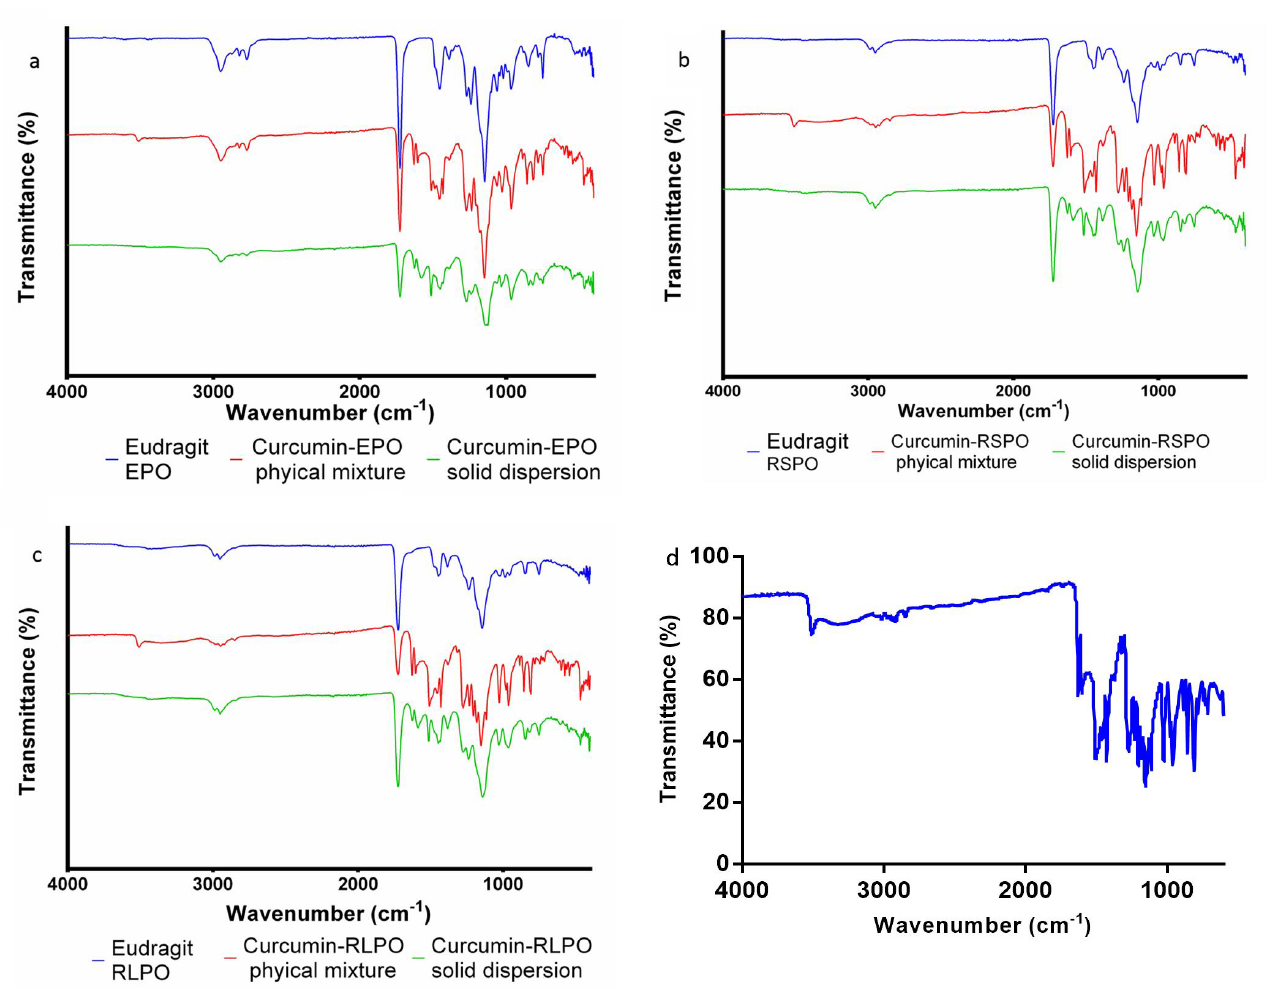
FIGURE 4 - Attenuated total reflecting-Fourier-transform infrared (ATR-FTIR) spectra of a: Eudragit E PO, physical mixture and curcumin Eudragit E PO solid dispersion; b: Eudragit RS PO, physical mixture and curcumin Eudragit RS PO solid dispersion; c: Eudragit RL PO, physical mixture and curcumin Eudragit RL PO solid dispersion; d: